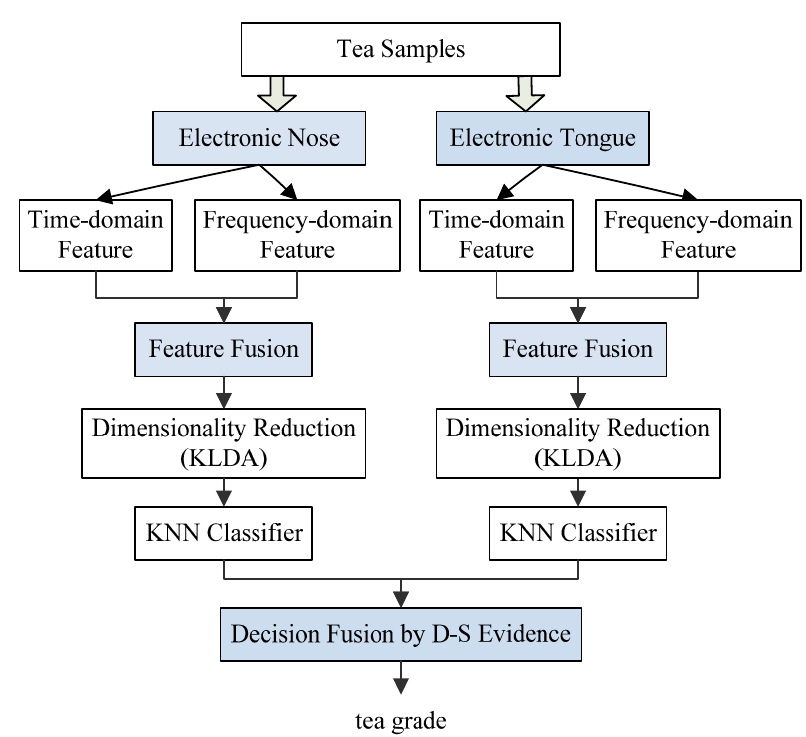
Figure 1. Illustration of the strategy flow of multi-level fusion tea quality assessment.